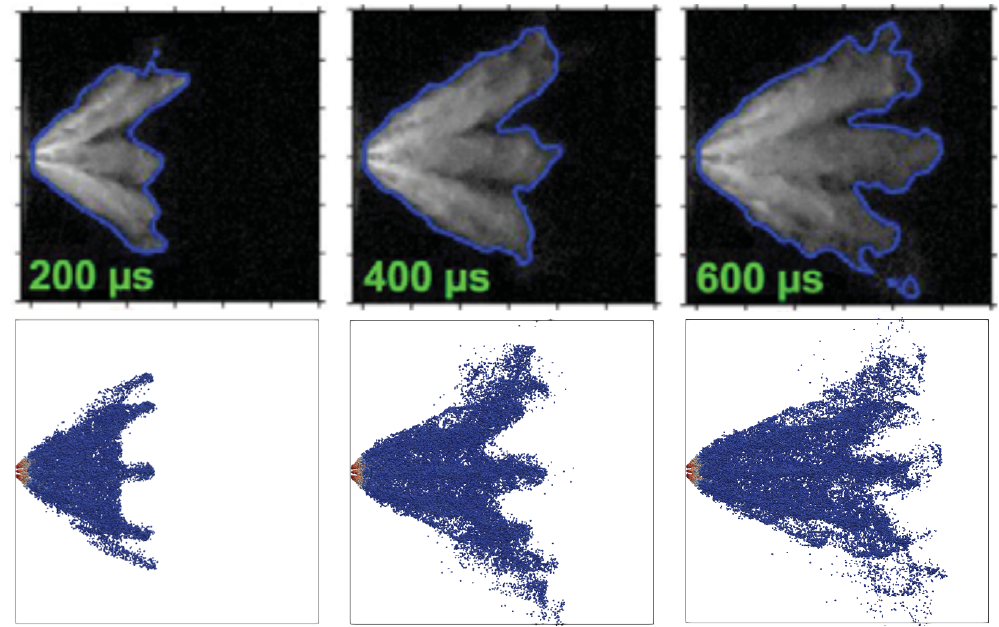
Figure 8. Liquid phase visualization. Comparison between the spray evolution as obtained from the experiments of Manin et al. [50] and from the present numerical DES simulation. In the images from the experiments, the detected liquid boundary contours are overlaid in blue. The reference time is indicated at the bottom-left corner of each panel reporting the experimental